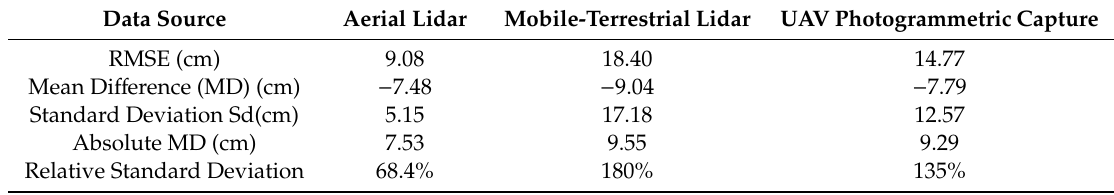
Table 2. Statistics Related to Di ff erence in Elevations for Di ff erent Data